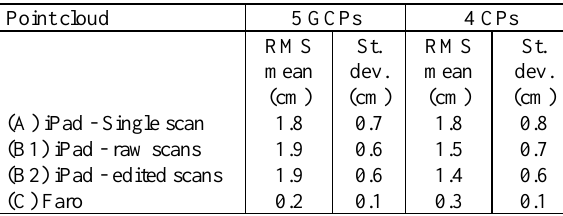
Table 5 . Evaluation of the point clouds positioning accuracy: RMS values on GCP/CP.